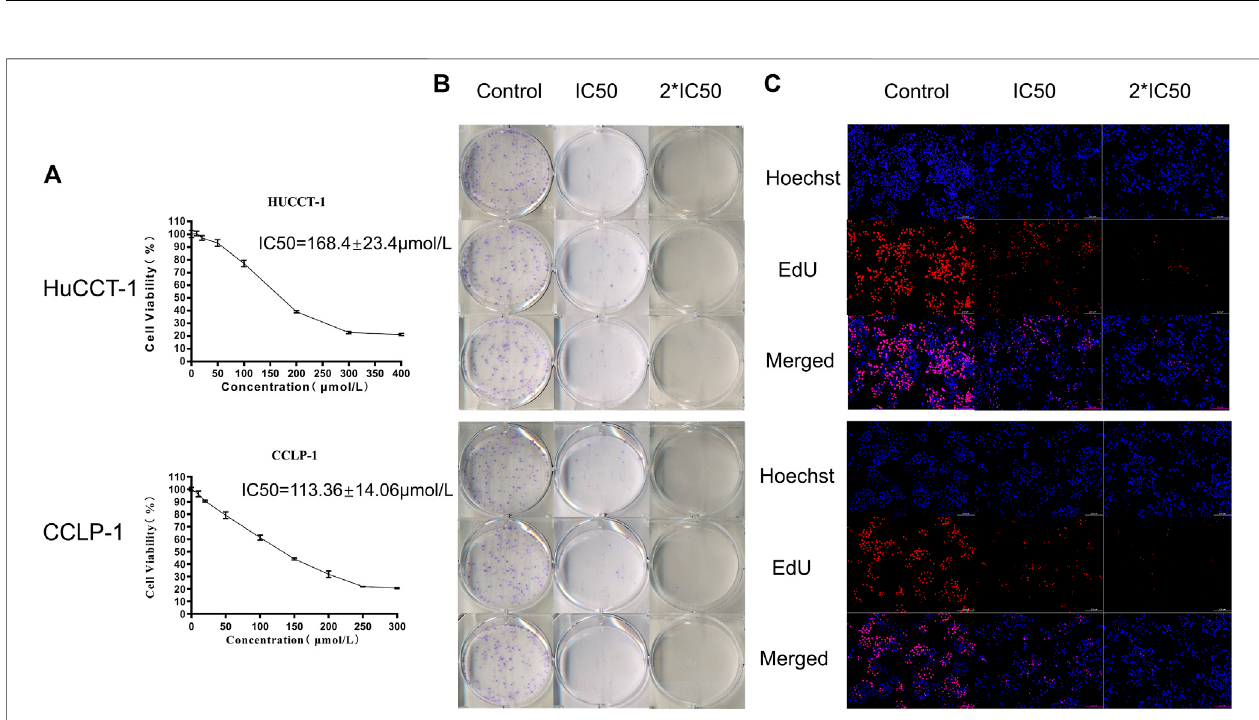
FIGURE 2 | HCQ inhibits cell viability in HuCCT-1 and CCLP-1 cells. (A) HCQ inhibited human cholangiocarcinoma cell viability. HuCCT-1 and CCLP-1 cells were treatedwithHCQindifferentconcentrationsfor24 h,andthecellviabilitywasmeasuredwiththeCCK-8assay(n (cid:2) 3).TheIC50concentrationwascalculatedaccording to its proliferation inhibition rate. (B – C) Colony formation assay and EdU assay results of HuCCT-1 and CCLP-1 cells treated with IC50 and 2*IC50 concentrations of HCQ.